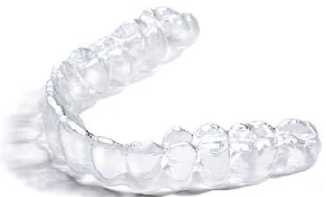
Figure 1. An example of maxillary clear aligner.